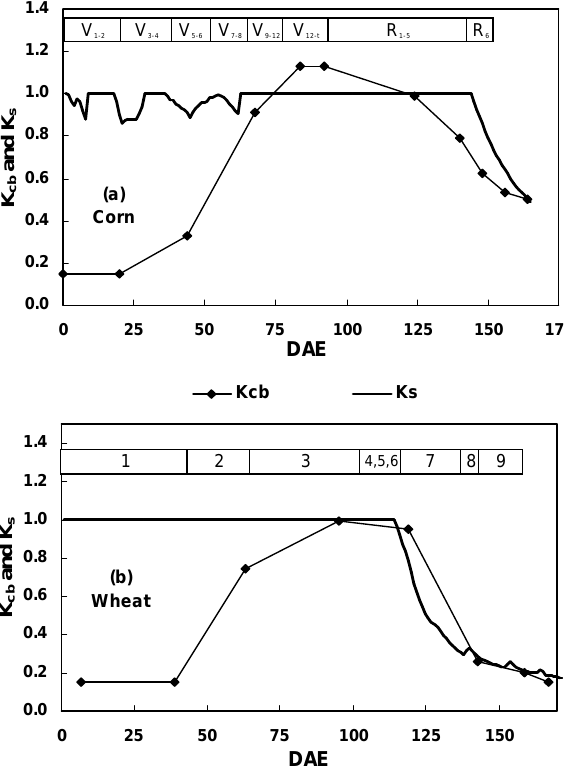
Fig. 7. Satellite-estimated basal crop coefficient and stress coeffi- Fig.7 Satellite-estimated basal crop coefficient and stress coefficient for corn 20 cient for corn (2009) (a) and wheat (2009) (b) . Ritchie’s (Ritchie (2009) (a) and wheat (2009) (b). Ritchie's (Ritchie and Hanway, 1982) and Zadok's 21 and Hanway, 1982) and Zadok’s stages for corn and wheat, respec- stages for corn and wheat, respectively, are also shown. 22 tively, are also